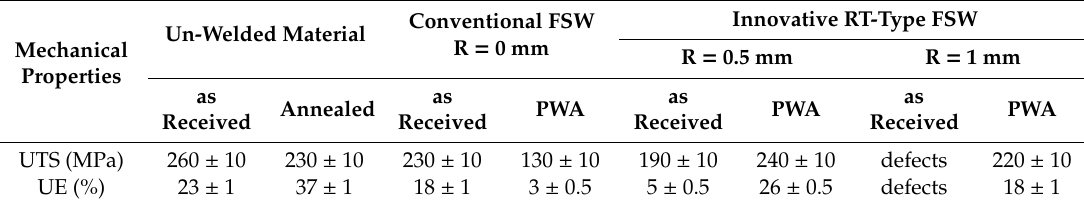
Table 2. Comparison between the mechanical parameters of RT-type FSW joints and conventional FSW ones evaluated by uniaxial tensile tests.